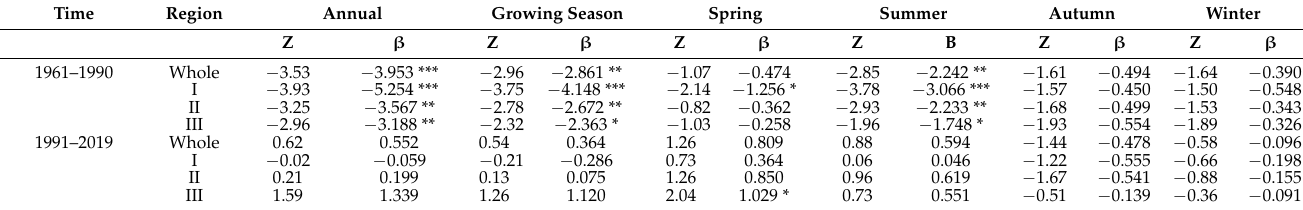
Table 1. Temporal trends of ET 0 during 1961–1990 and 1991–2019 in Anhui province.